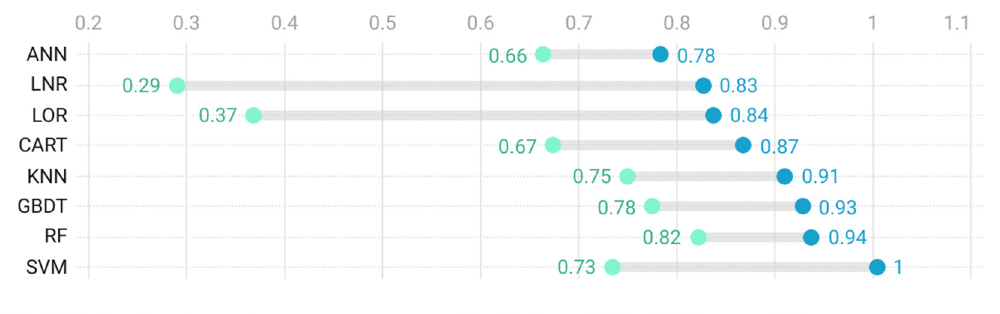
Table 9. Variances of eight algorithms.